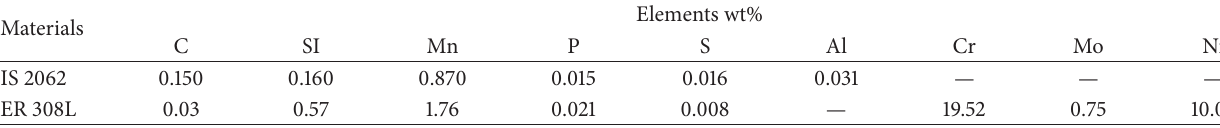
Table 1: Chemical composition of base metal and filler wire.